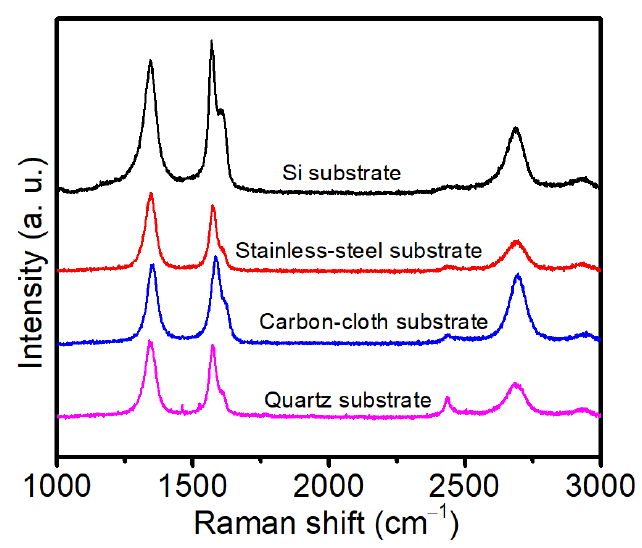
Figure 4. The Raman spectra of VFLG grown on different substrates. Table 2. The parameters extracted from Raman spectra for the VFLG grown on different substrates. Substrate